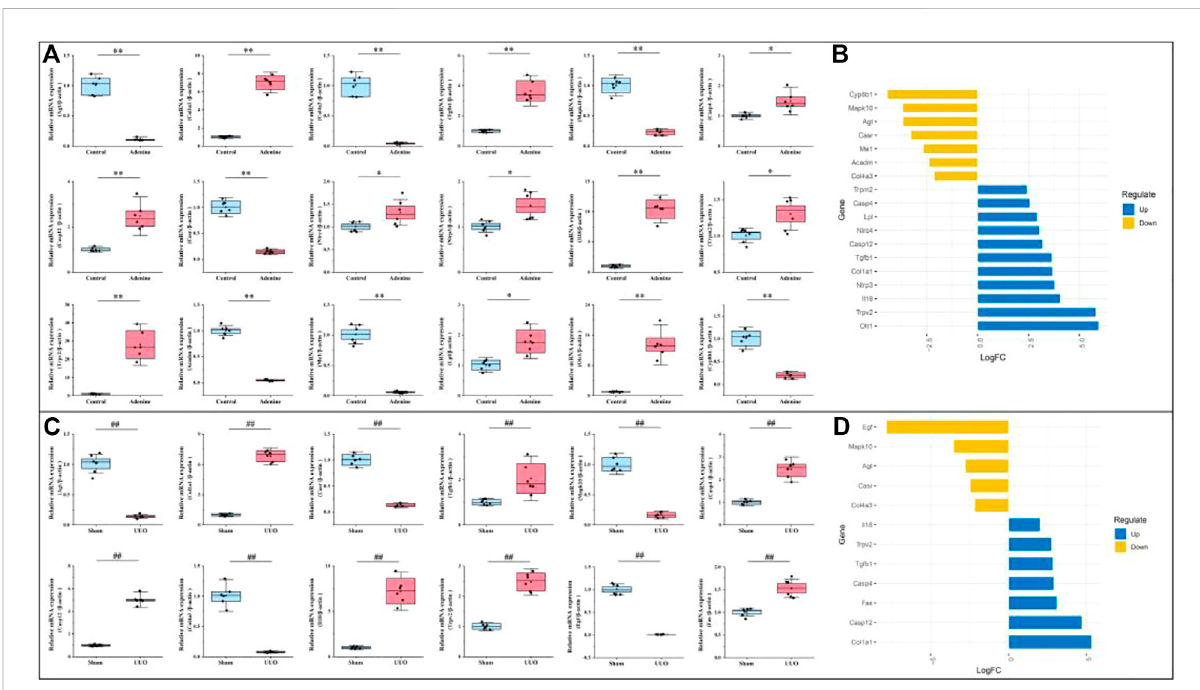
FIGURE 8 Veri fi cation of RF-related DEGs using qRT-PCR. (A) The gene expressions of Agt, Col1a1, Col4a3, Tgfb1, Mapk10, Casp4, Casp12, Casr, Nlrc4, Nlrp3, Il18, Trpm2, Trpv2, Acadm, Me1, Lpl, Olr1, and Cyp8b1 in the adenine model. (B) Deviation plot of RF-related DEGs in (A) was represented to ensure that gene expression trends in qRT-PCR and RNA-seq were consistent. (C) The gene expressions of Agt, Colia1, Col4a3, Mapk10, Tgfb1, Casp4, Casp12, Casr, Il18, Trpv2, Egf, Fas in the UUO model. (D) Deviation plot of RF-related DEGs in (C) was represented to ensure that